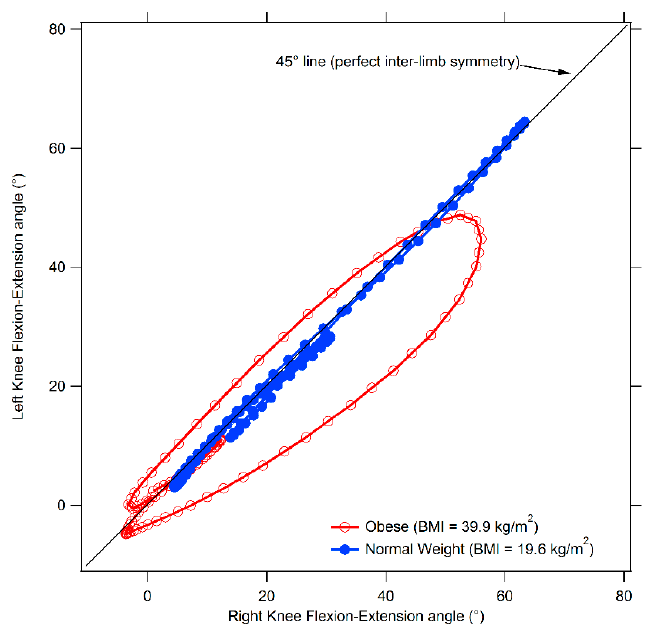
Figure 1. Comparison between cyclograms of obese and normal weight individuals. The diagram refers to the knee joint.